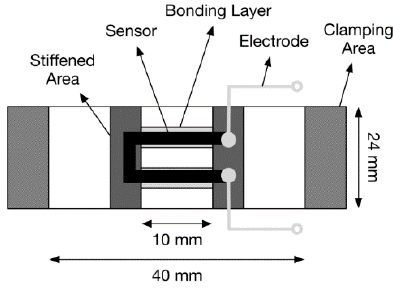
Figure 3. Schematic description of the textile band sensor tensile specimen; electrodes were connected at the ends of the U.